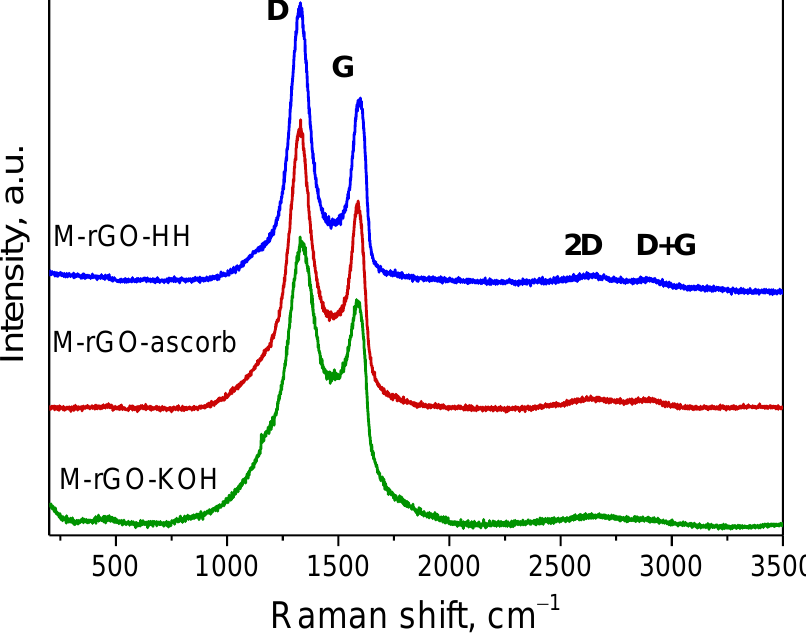
Figure 8. Raman spectra of samples of melamine – rGO composites: M – rGO – KOH, M – rGO – ascorb and M – rGO – HH.